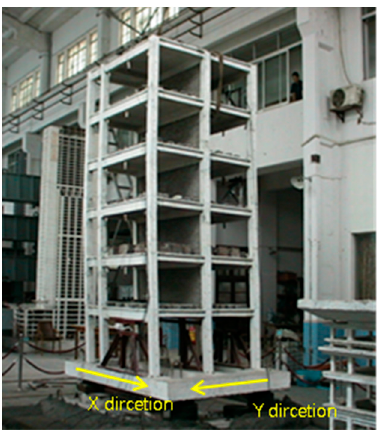
Figure 2. Six story reinforced concrete frame structure.